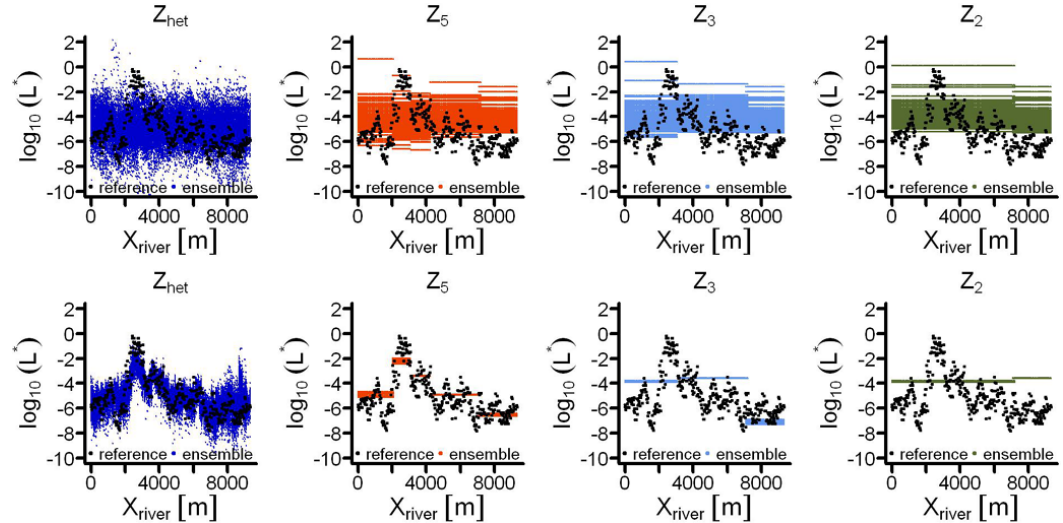
Fig. 14. Ensembles of leakage coefficients (coloured) and reference field (black) along the river reach at day 1 (upper row) and at day 600 (lower row) for scenario C. Distance X river is calculated starting from the two most western river nodes. L ∗ has units m s − 1 .